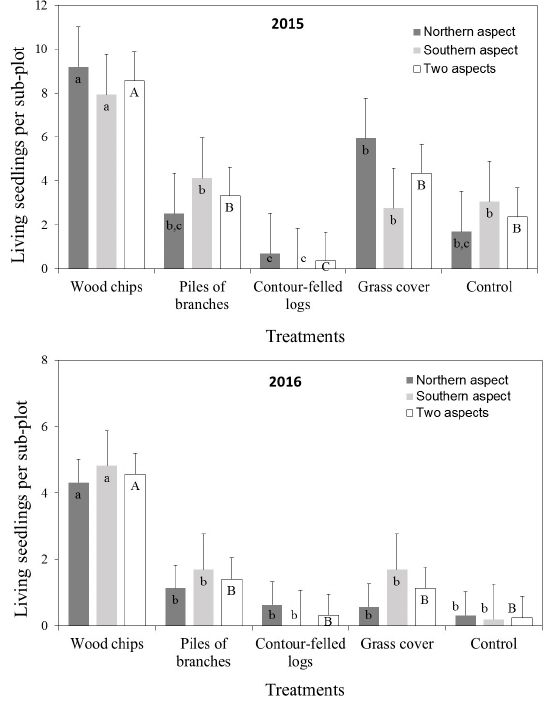
Figure 5. Mean values (±SE) of total seedling survival per sub-plot (in untransformed units; living seedlings) depending on the seeding method (treatment) and aspect (years 2015 and 2016). The bar chart shows the values for the two aspects (data-pooled) and within aspects (northern or southern). For the two aspects, the means with same capital letter were not significantly different, and the means within aspect with the same lowercase letter were not significantly different (at the 0.05 level according to the LSD test, in all cases). Sample data = 160 sub-plots (80 within each aspect). Total seeded sub-plots (50 × 50 cm) per treatment (seeding method) =